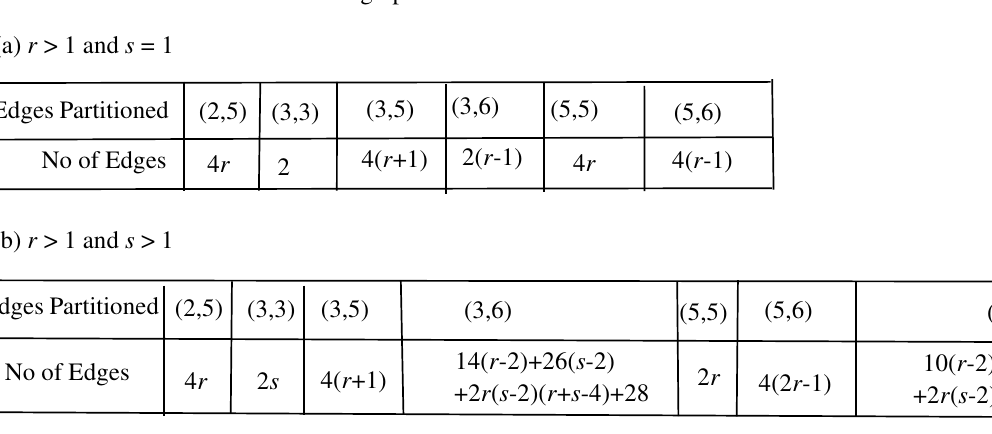
Table 2: Semi-total line graph of